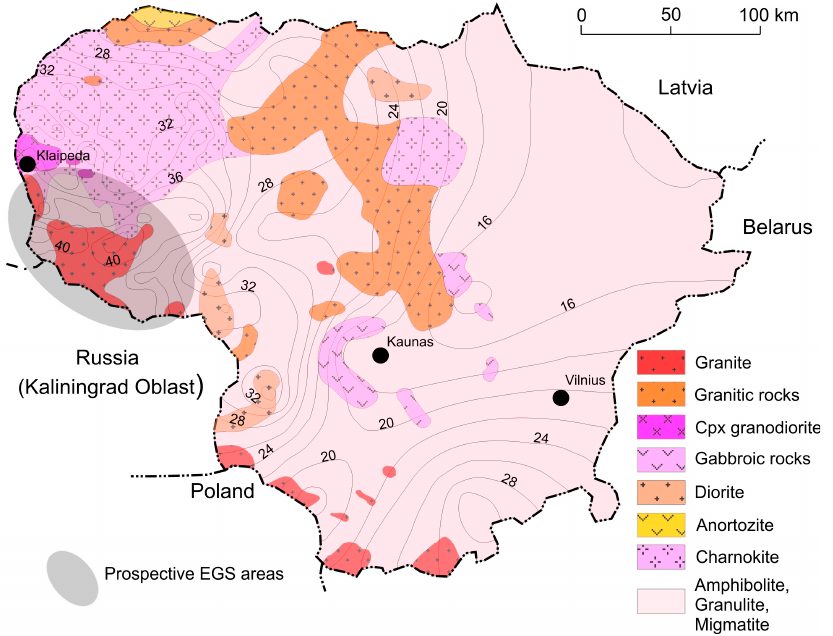
Figure 4. Generalized map of the Lithuanian crystalline basement in the background of geothermal gradient distribution (based on [40,42] ).